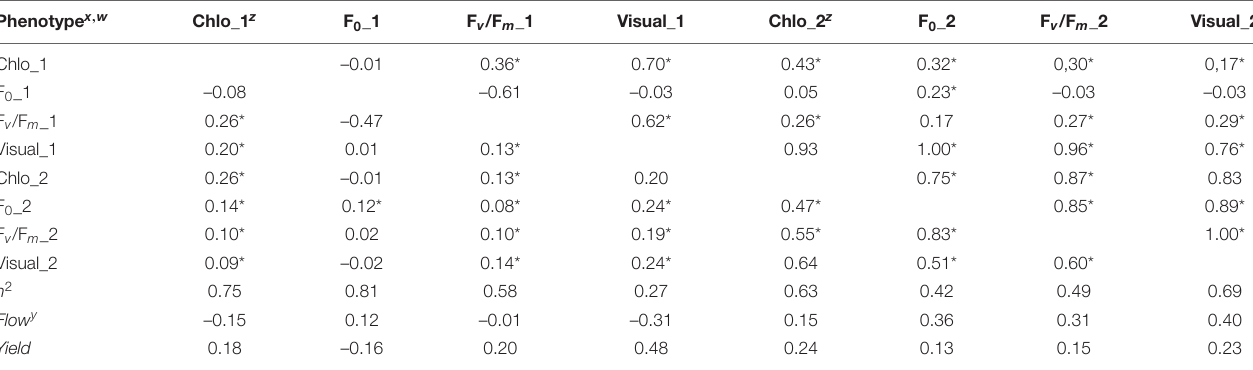
TABLE 2 | Genotypic and phenotypic correlation coefficient matrix of physiological traits and senescence visual appearance evaluated in the MAGIC population EPS21 across two environments in Pontevedra, Spain. Phenotype x ,